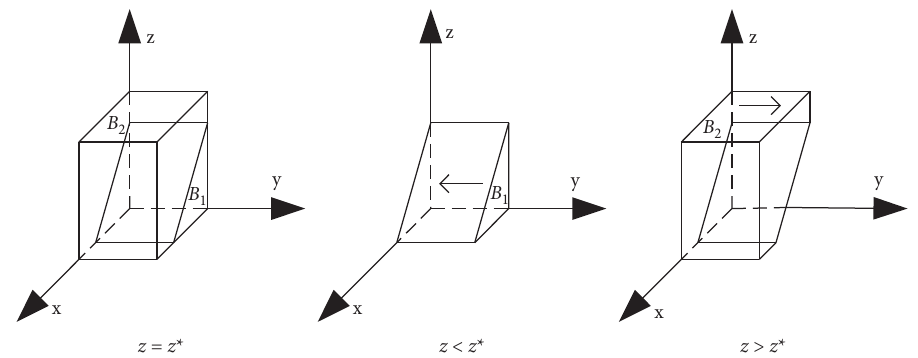
Figure 3: Strategy evolution phase diagram of the third